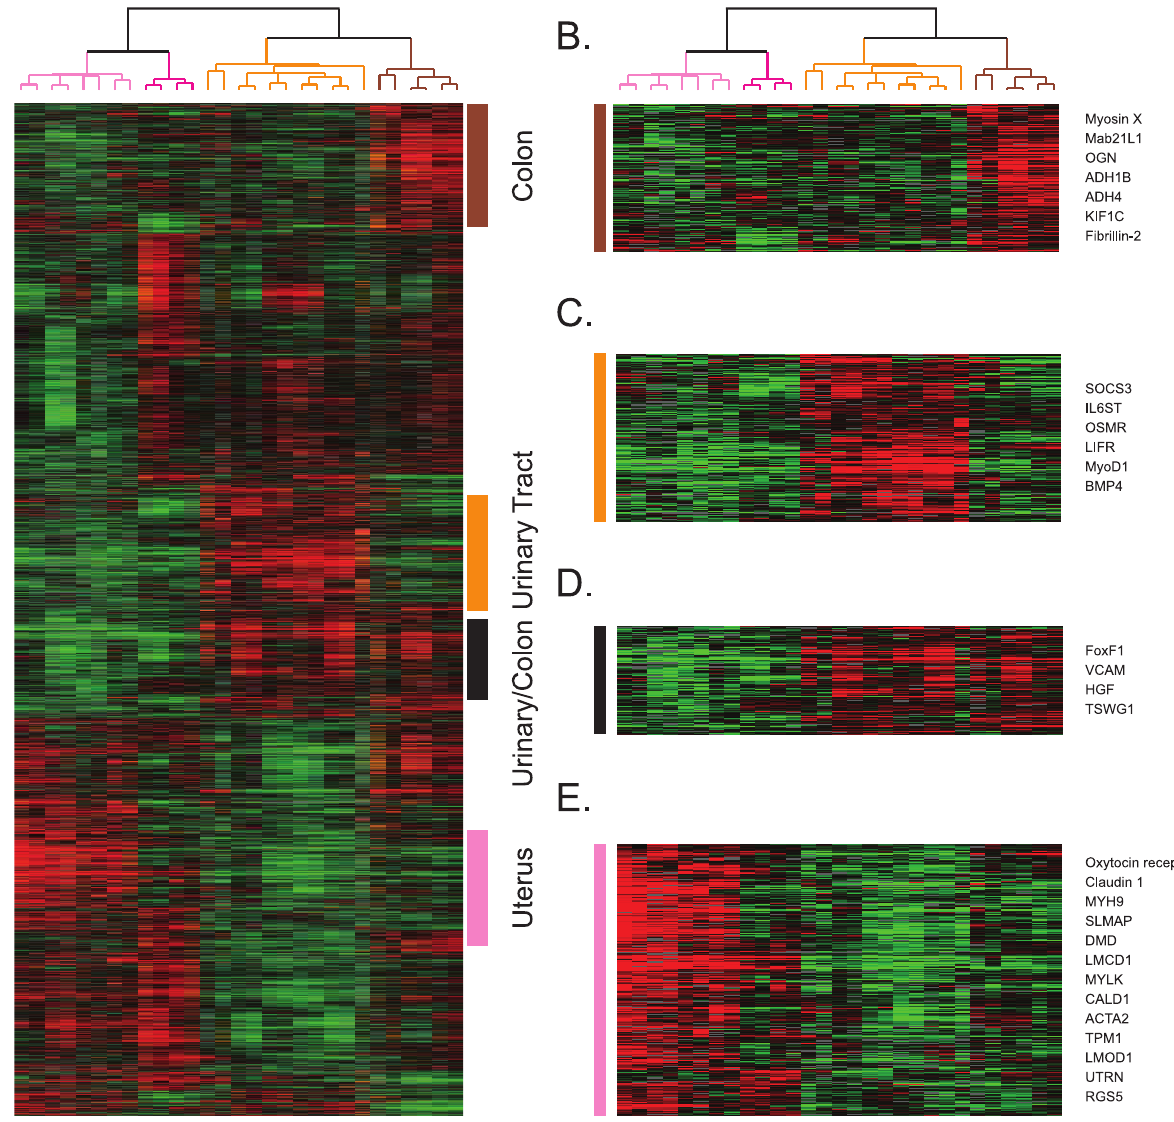
Figure 4. Colon-, Urinary Tract-, and Uterus-Specific Gene Expression programs (A–D) Colon-, urinary tract-, cervix- and uterus-specific gene expression identified by a multi-class SAM analysis are shown in (A) and names of select genes are expanded in (B–E). Named genes are colon specific (B, brown bar), urinary tract specific (C, orange bar), urinary/colon specific (D, black bar) and uterus specific (E, pink bar). Complete data can be found on the supplementary Web site and SMD.